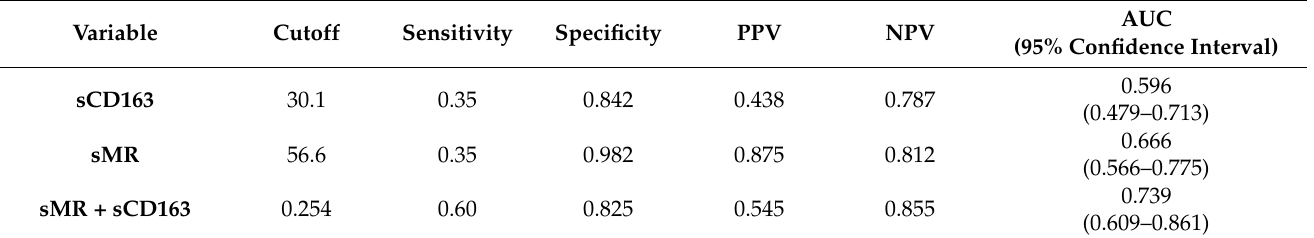
Table 2. Diagnostic accuracy of intestinal permeability markers for symptom development in patients with primary biliary cholangitis.